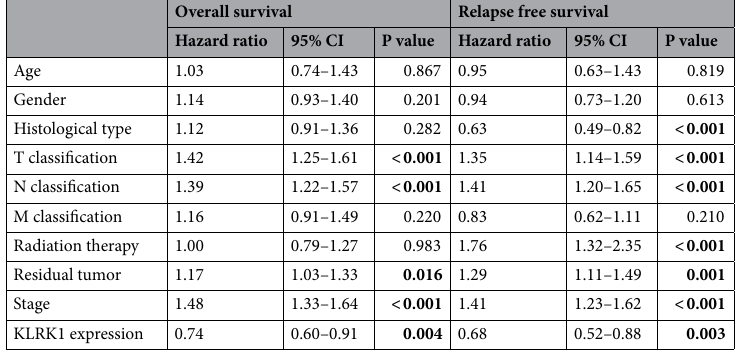
Table 3. Univariate analysis of overall and relapse free survival in patients with lung cancer.